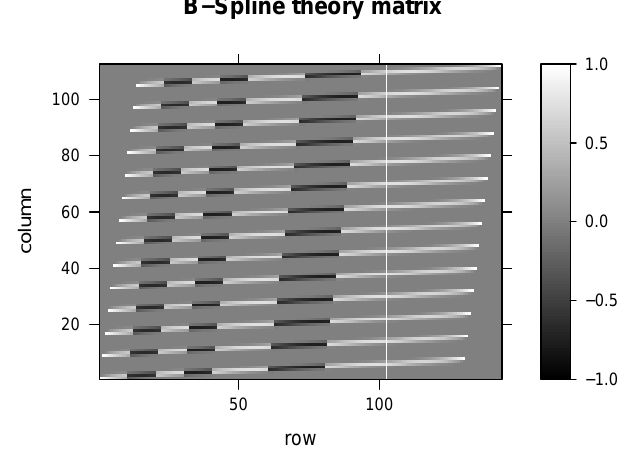
Fig. 2. A theory matrix for a range and Doppler spread target with N r = 14 range gates and N s = 8 B-spline guide points per range. The code is a simple 13-bit Barker code with 10 samples per baud.